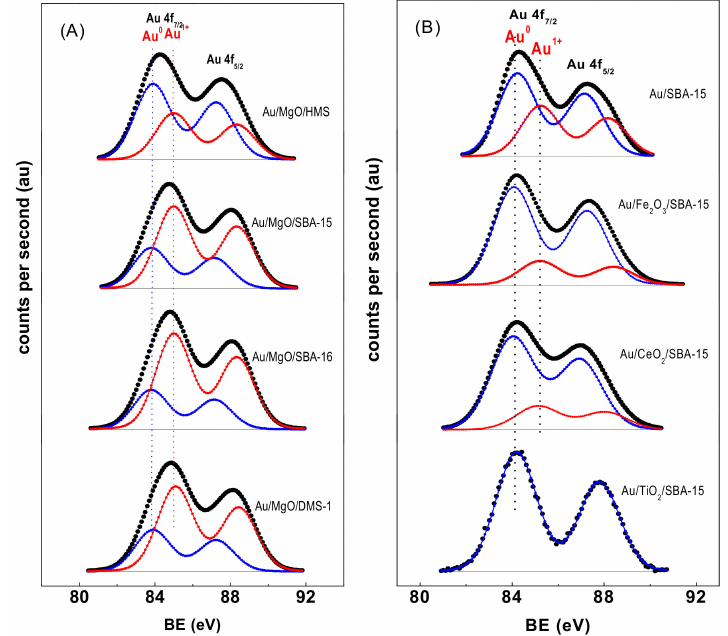
Figure 8. ( A ) XPS curve-fitting of the Au 4f photoelectron peak in the Au catalysts supported on different MSM ( A ) and on SBA-15 modified with reducible metal oxides ( B ).